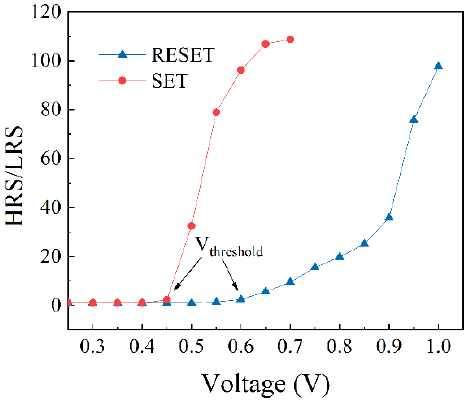
Figure 3. Resistance switching in the Ti/HfO 2 : Al/Pt device following the sequence of voltage pulses with varying amplitudes. The current range was set to 10 mA. (V read = 0.1 V). The typical dynamic current responses of the voltage pulse are shown in Figure 4.